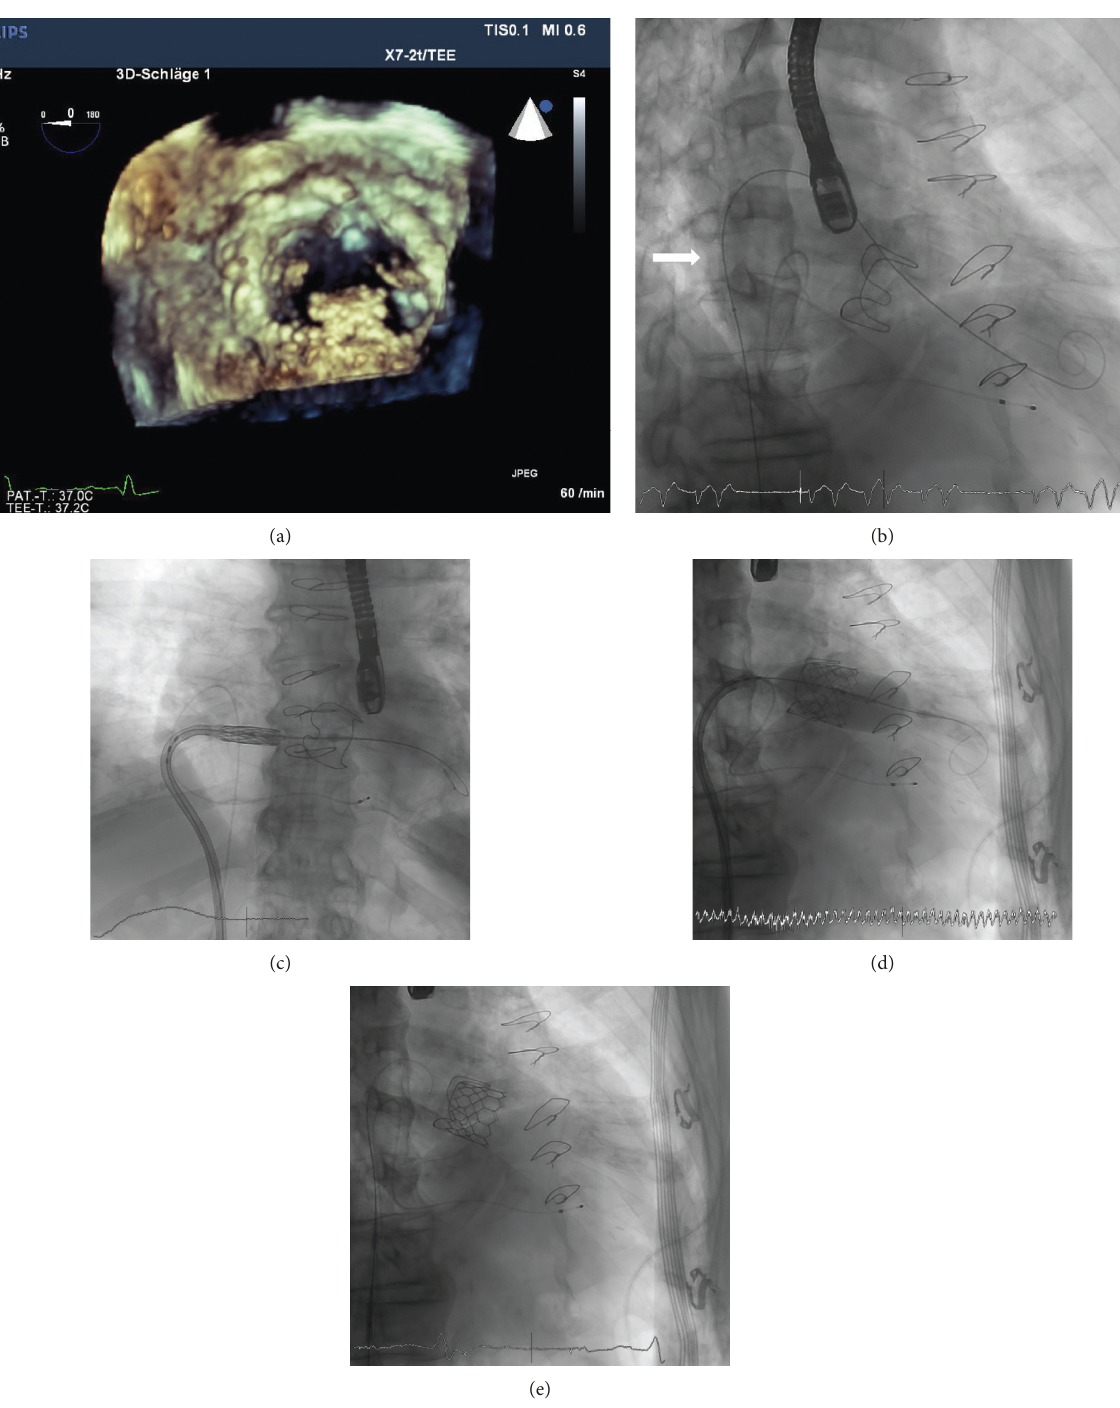
Figure 2: TMVI-VIV: (a) 3D -TEE shows degenerated biological mitral valve prosthesis (Carpentier Edwards 31mm biological mitral valve prosthesis) with calcified and thickened leaflets (view from left atrium). (b) Fluoroscopy shows balloon dilatation (Osypka VACS II 12 × 40mm Balloon, Osypka AG, Germany; white arrow) of the interatrial septum to create an artificial atrial septum defect prior to insertion of the prosthesis into the left atrium. (c) Fluoroscopy shows the ES 3 prosthesis after insertion into the left atrium. (d) Fluoroscopy shows the implantation of the ES 3 prosthesis into the malfunctioning biological mitral valve prosthesis. (e) Fluoroscopy shows the final result of the mitral valve-in-valve